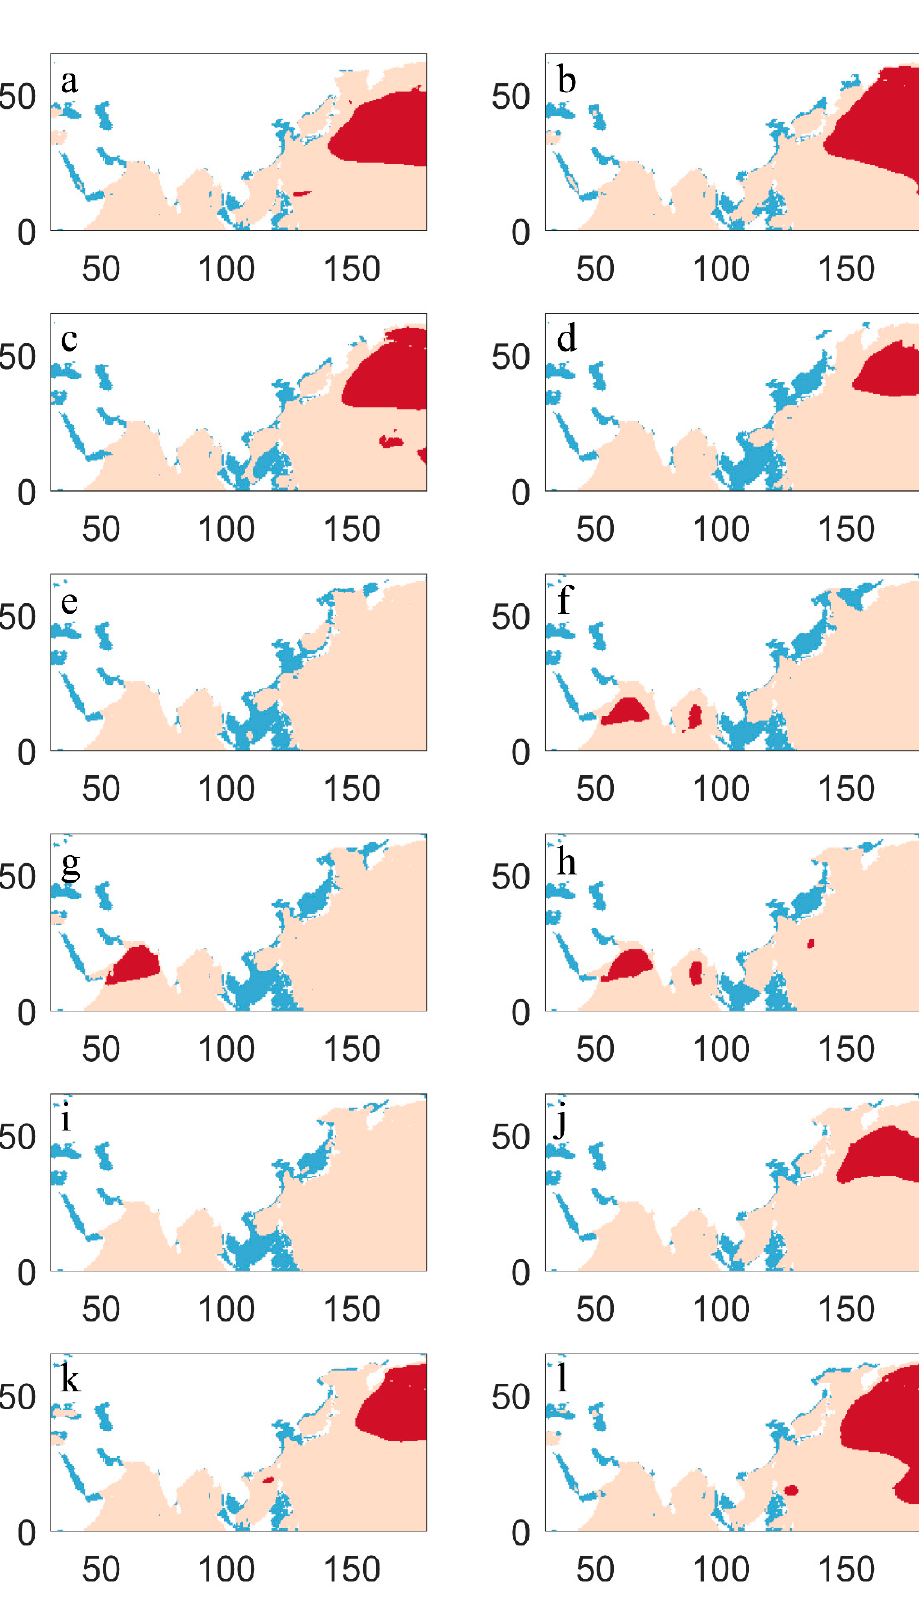
Figure 9. Selection of the maximum limited angle in different months: ( a ) January, ( b ) February, ( c ) March, ( d ) April, ( e ) May, ( f ) June, ( g ) July, ( h ) August, ( i ) September, ( j ) October, ( k ) November, and ( l ) December.